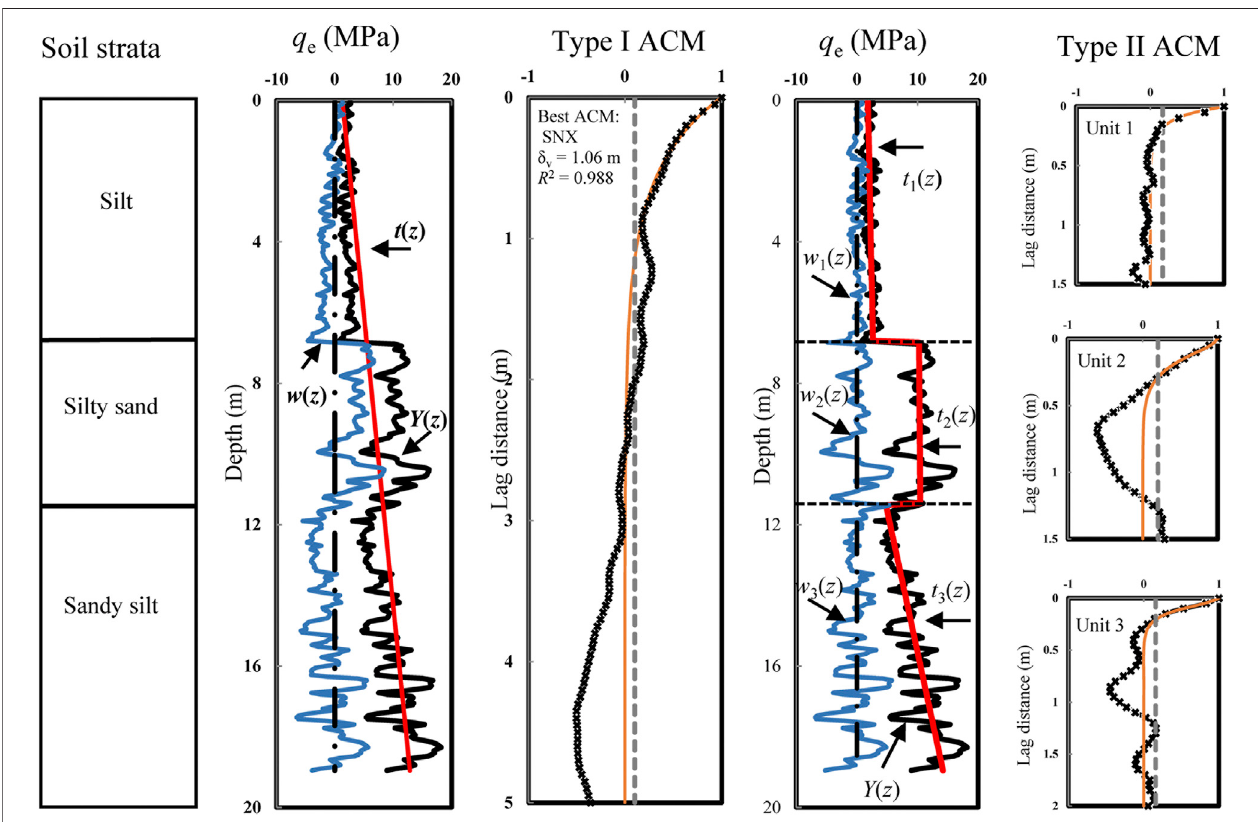
FIGURE 5 | Estimation of random fi eld parameters of the q e pro fi le in Case 1.